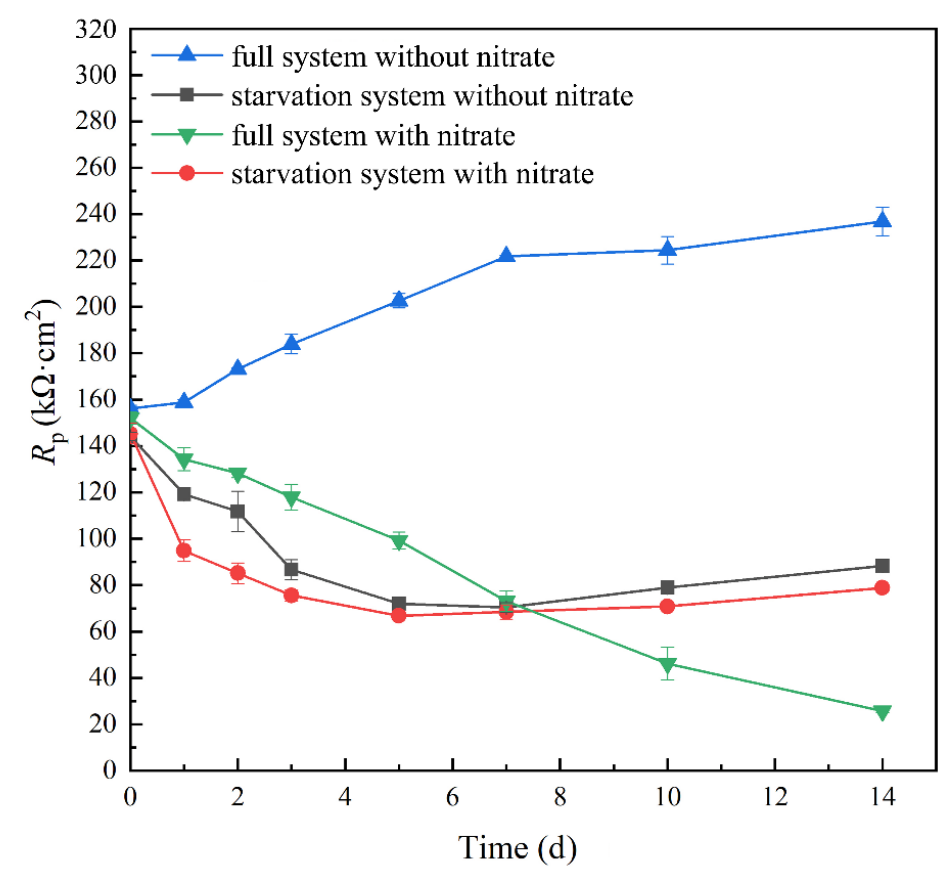
Figure 8. Time dependence of R p in different systems.